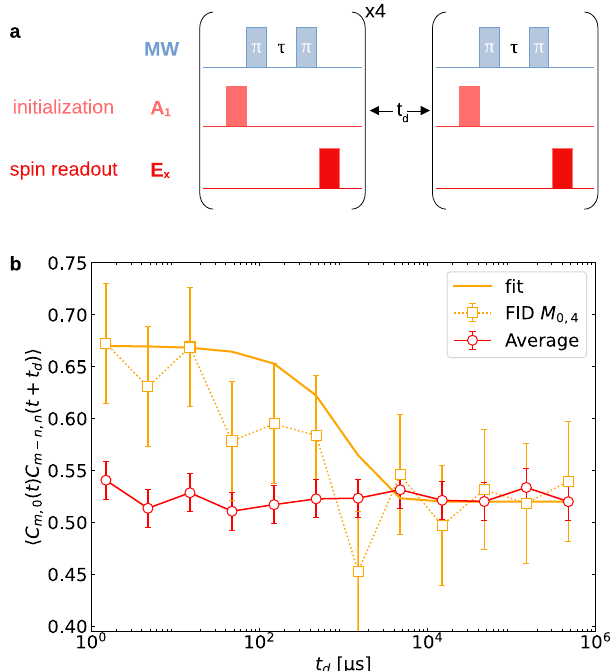
Fig. 4 | Measuring the lifetime of the puri fi ed bath-state via qubit-state auto- correlation.a Thepulsesequenceusedforthemeasurement.Aftertheconditional bathstatepuri fi cationbyCT M 0,4 ,weallowawaitingtime t d (plottedonalog-scale) and then measure again the probability of obtaining an identical measurement result for the qubit. b The probability of obtaining the result 0 after a long waiting (delay) time t d for bath state preparations via M 0,4 (orange) is shown for mea- surement intervals τ =1.2 μ s. The fl at part of the orange curve marks a long auto- correlation time for the qubit. These probabilities are compared with the case without bath puri fi cation (red), where the auto-correlation time is much shorter. The effective lifetime of the bath, following puri fi cation, is seen to extend towards the T e 1 lifetimeoftheprobe.Furtherdetailsontheerrorbaranalysisaregiveninthe “ Methods ”